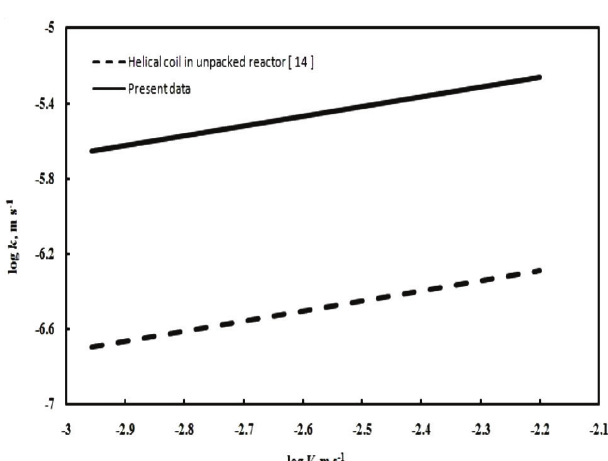
Fig. 4 – log k vs. log d at different Re and Sc (Coil tube p diameter = 0.01 m)